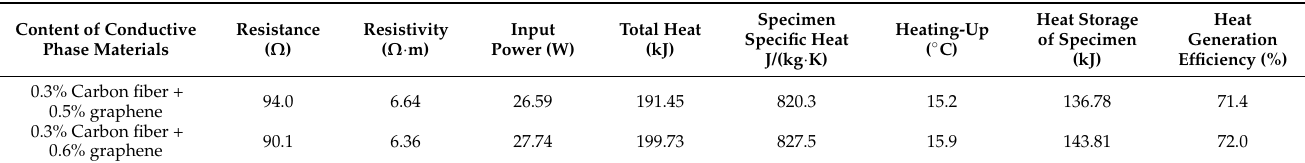
Table 21. Results of temperature rise and heat test of rut plate